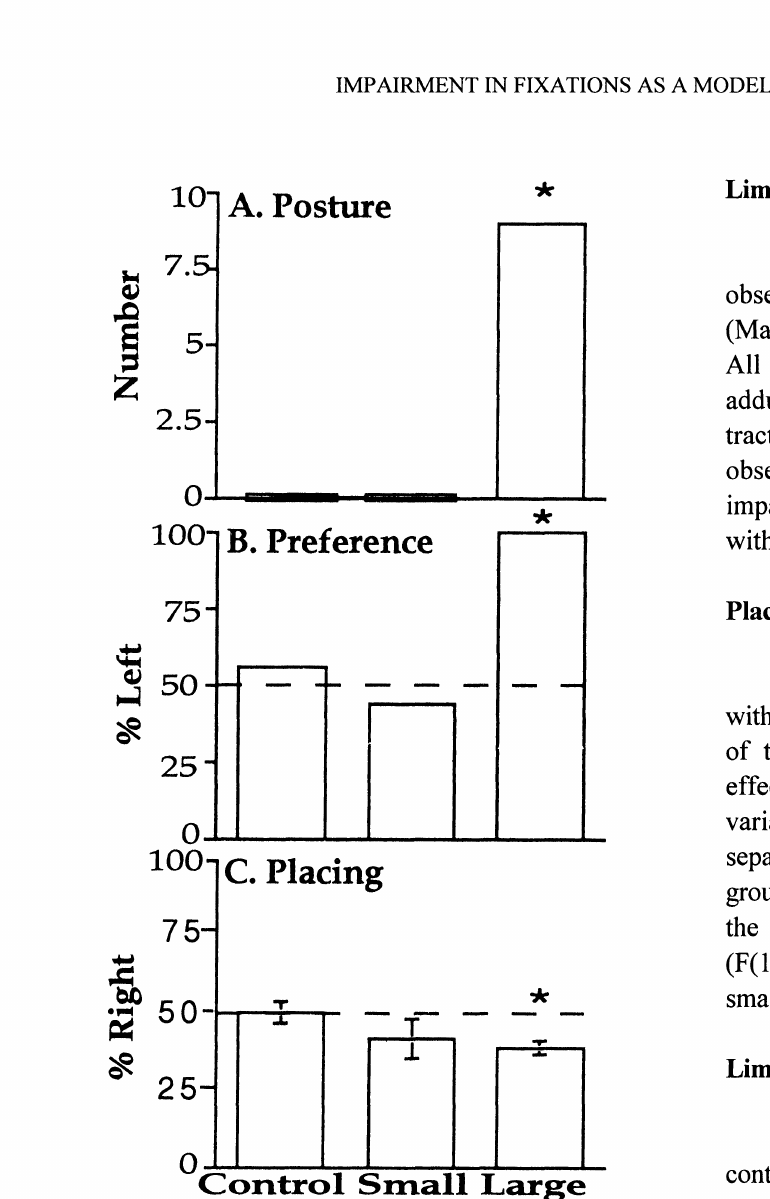
Fig. 2: Limb performance (mean and SE) of control and pyramidal tract lesion (lesion) rats on three tests of limb use (right paw paw contralateral to the lesion). A. Posture. Rat was held by the tail, head down, and the number displaying forelimb adduction with the contralateral forelimb was counted. B. Reach. The number of rats displaying a preference for a particular forepaw when initially trained to reach in the tray-reaching task. C. Placing in the cylinder test. Contacts with the wall by each forepaw were counted. Note that rats with complete pyramidal tract lesions displayed significantly (**p<0.05) more postural abnormalities in the paw contra-lateral to the lesion, preferred the ipsilateral paw for reaching, and made significantly fewer contacts with the cylinder with paw contralateral to the